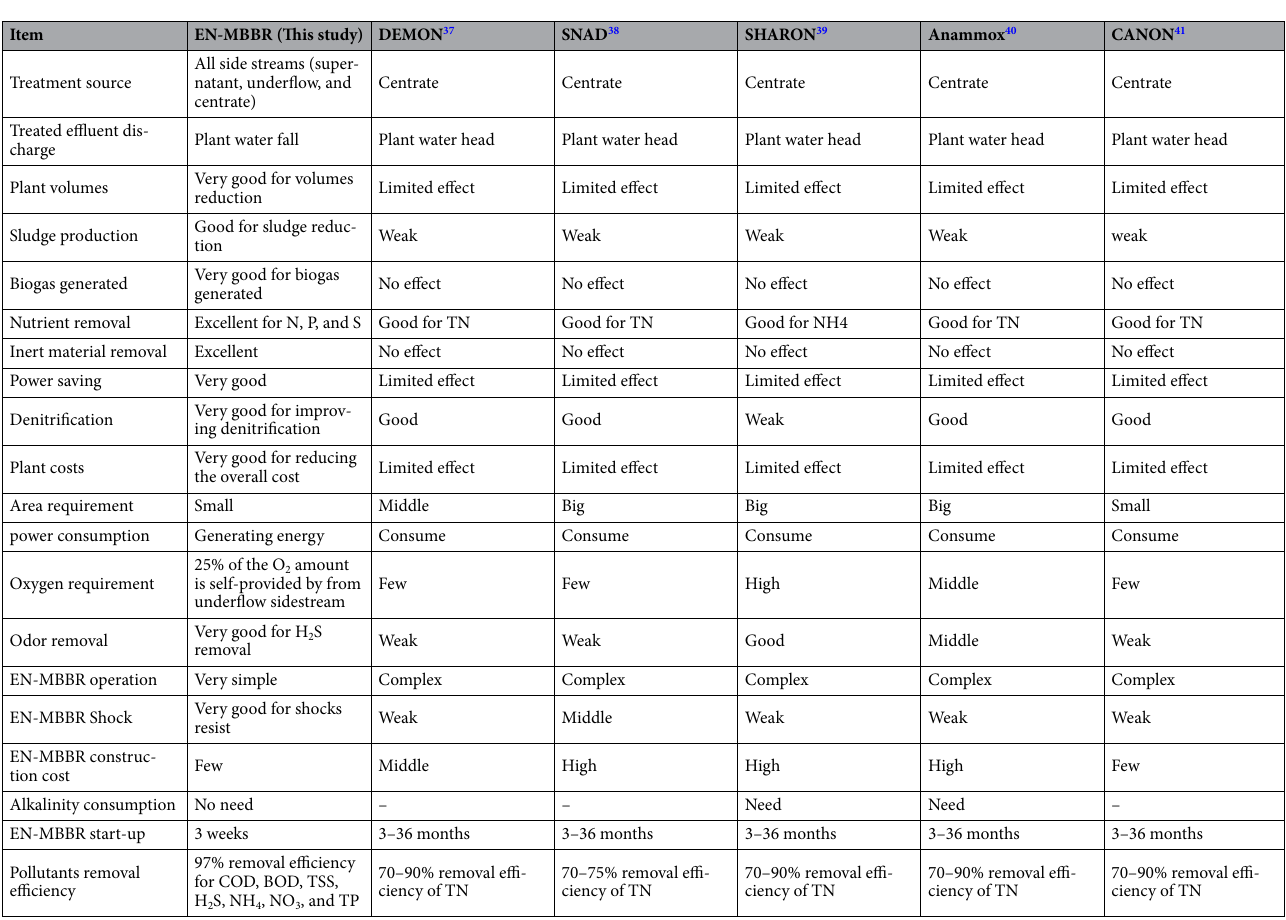
Table 12. Comparison of the EN-MBBR system with other